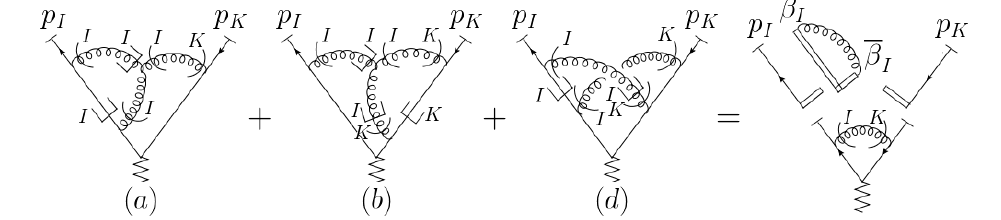
Figure 38. The graphic contributions to P